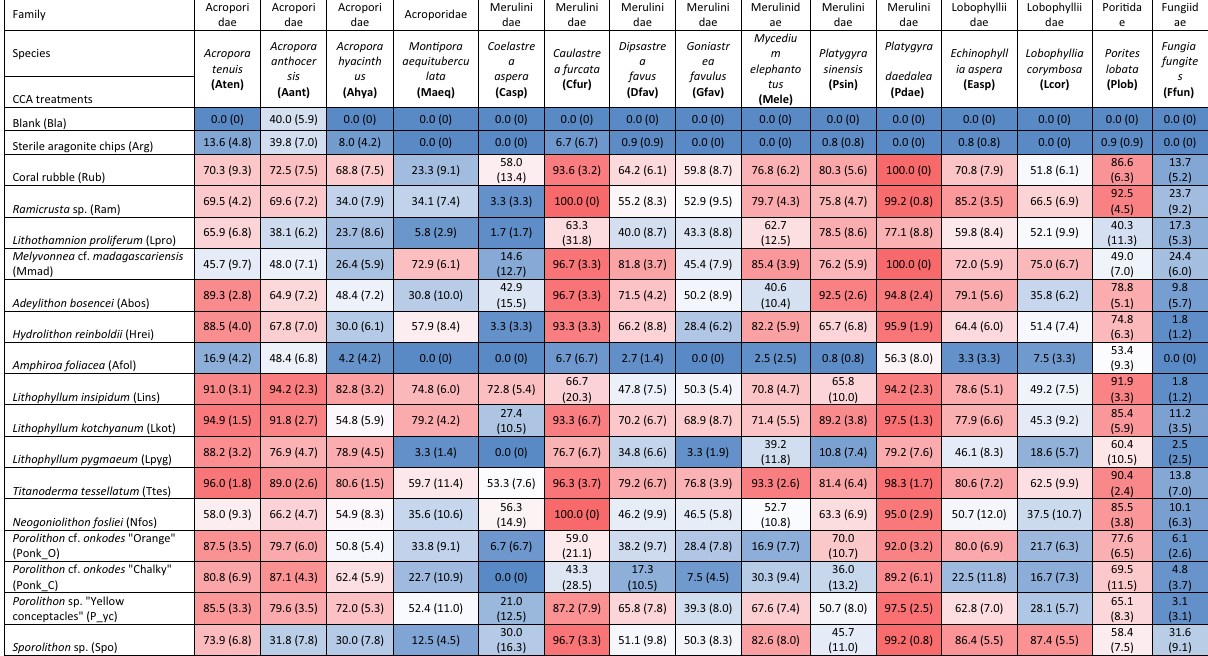
Table 3. Mean total settlement (%; SE in parentheses) of coral larvae from 15 species across 5 taxonomic families when presented with 15 common encrusting red algal species across 8 taxonomic families from the Great Barrier Reef. Coral and CCA abbreviations are provided in parentheses. Cells with warmer colours represent higher settlement values. Refer to Table 1 for details on coral larval